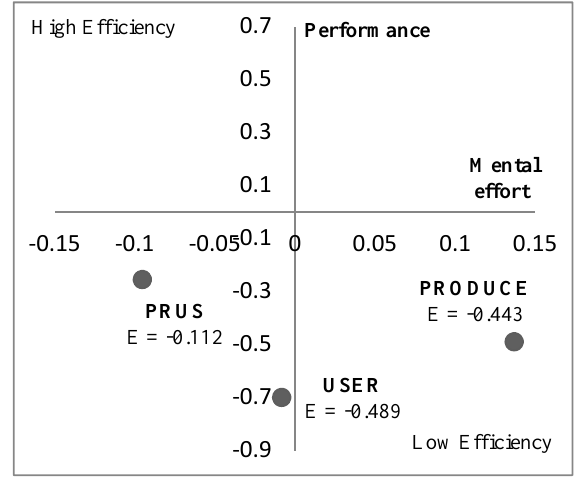
Figure 5. Representation of relative condition efficiency (E) for producing screencast (PRODUCE), produce and user of screencast (PRUS) and user of screencast (USER) for difficult